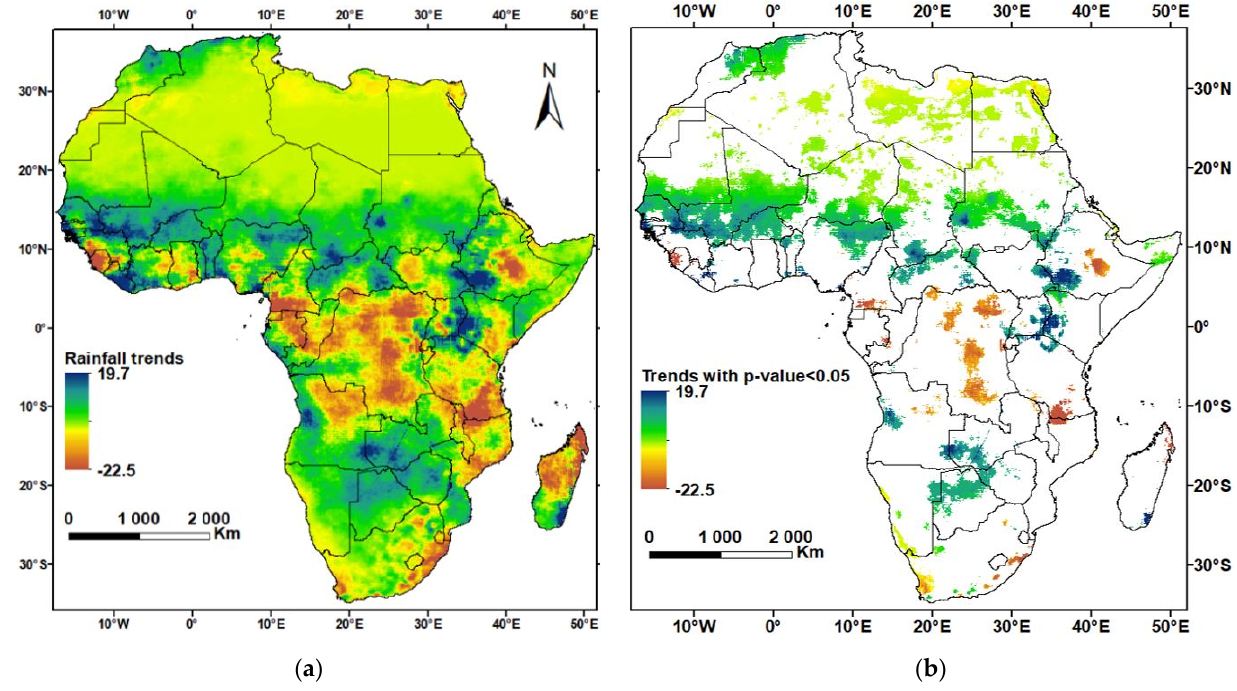
Figure 3. Statistical analysis of mean cumulative rainfall in all the climate zones of Africa from 1982 to 2015.